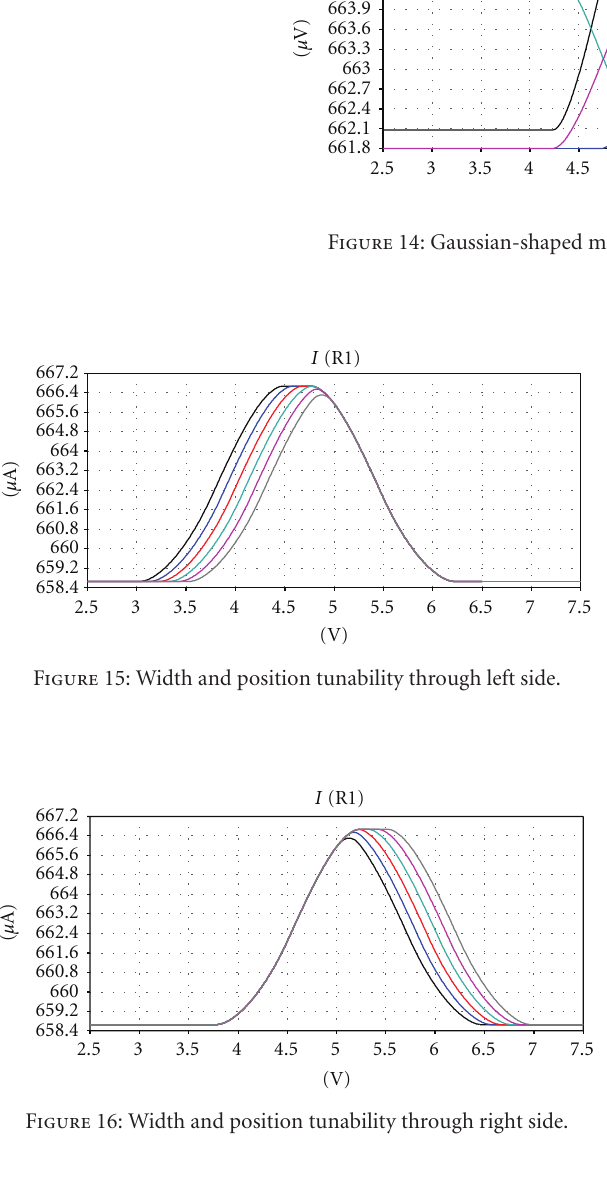
source I applied , with identical drain resistance R d . V g1 and V g2 are two input voltages applied at the gates G1 and